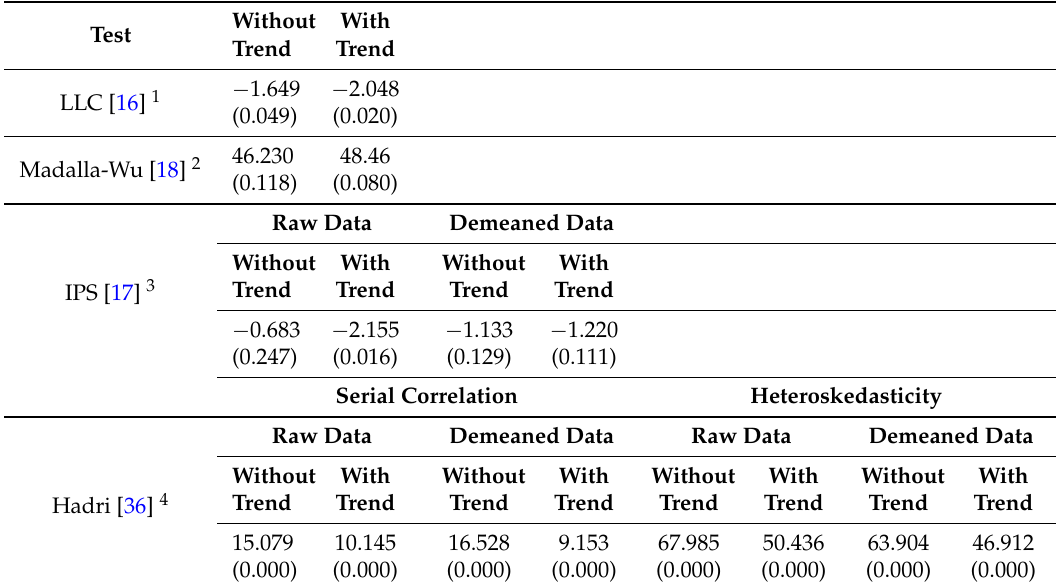
Table 3. 1st generation panel unit root test result